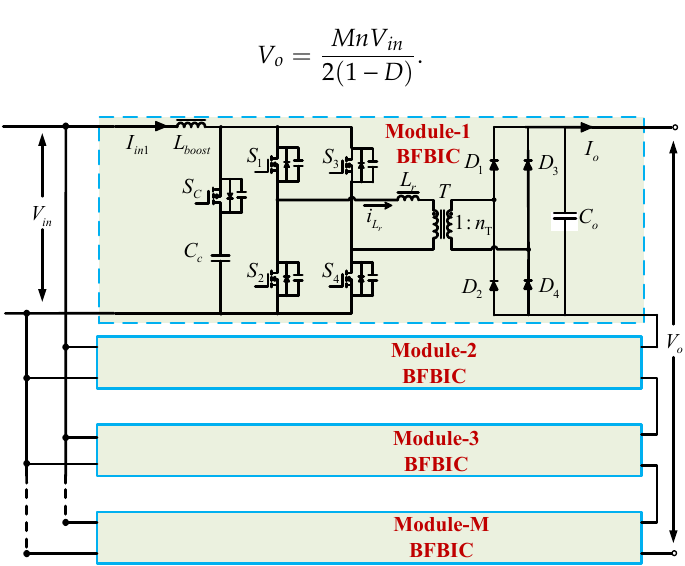
Figure 2. The topology of the combined converter.